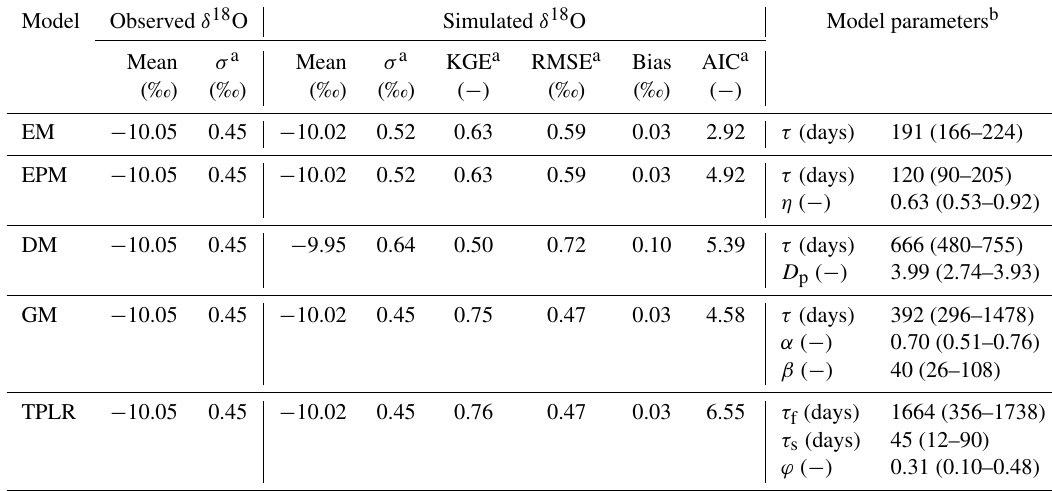
Table 5. Statistical parameters of observed and modeled δ 18 O for the stream at the outlet of the basin (M8).